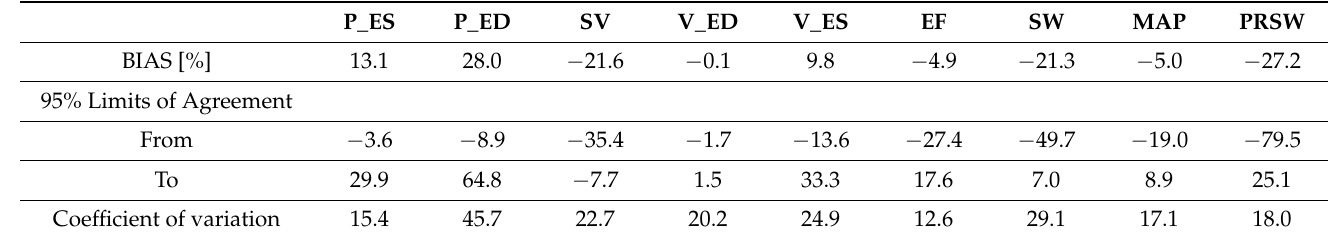
Table 2. Results of the Bland–Altman analysis. Shown are the mean of the difference between in vivo data and simulation in percentage (BIAS [%]), 95% limits of agreement, and coefficient of variation for the end-systolic and -diastolic pressure (P_ES, P_ED), stroke volume (SV), end-diastolic and -systolic volume (V_ED, V_ES), ejection fraction (EF), stroke work (SW), mean arterial pressure (MAP), and preload recruitable stroke work